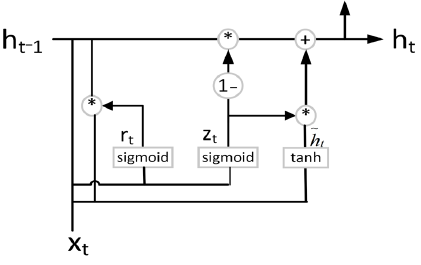
Figure 5. Structure of GRU.